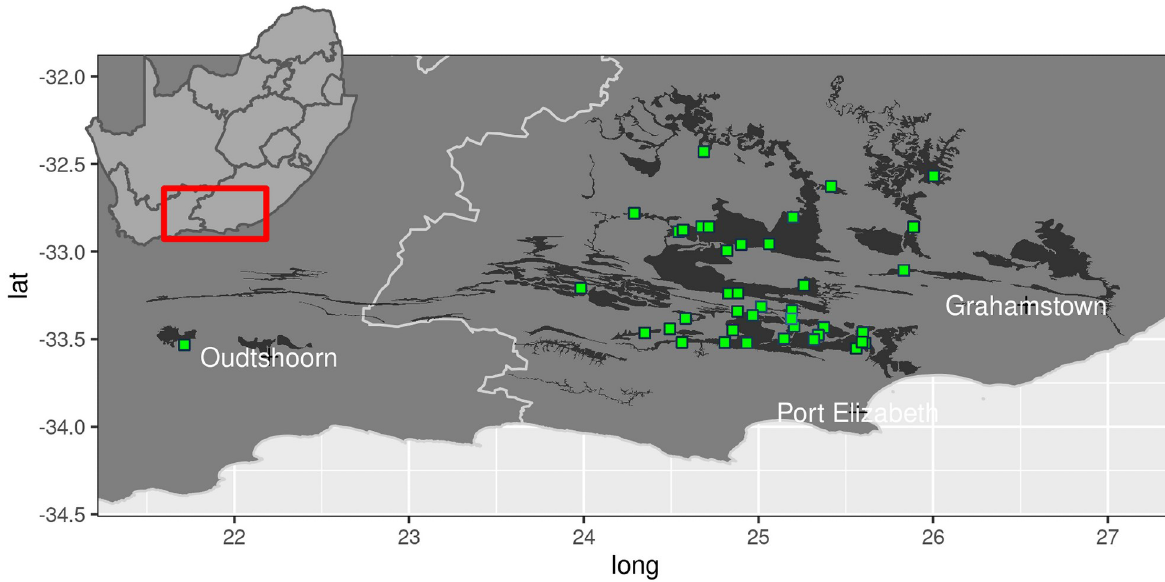
Fig 2. Map of the study region showing the extent of the spekboom thicket vegetation (dark shading) and location of the 40 experimental plots used in this study (green